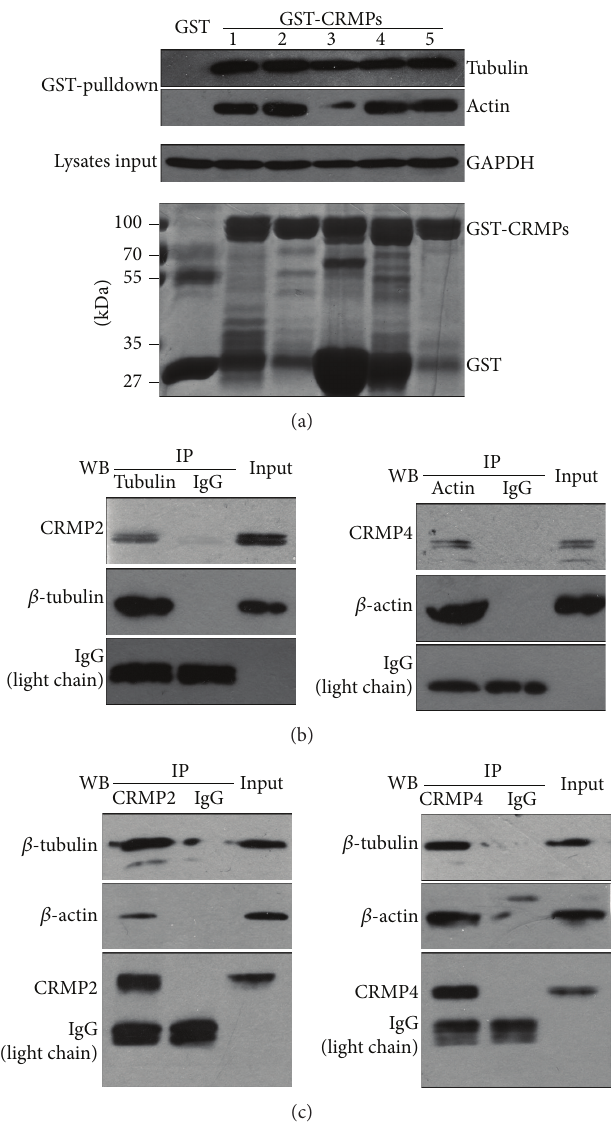
Figure 1: CRMP2 and CRMP4 interact with tubulin and actin. (a) Bacterial recombinant glutathione S-transferase- (GST-) CRMPs were purified and subjected to GST-pulldown assays with growth cone extracts from rat brain. Coomassie blue staining of GST and GST-CRMPs (bottom) showed equal loading of bait proteins. The pulldown sediments were subjected to western blot assays with tubulin and actin antibodies using GAPDH as the lysate input control. Each result is representative of three to five separate experiments with similar results. (b) Growth cone lysates from rat brain were subjected to coimmunoprecipitation (Co-IP) with tubulin or actin antibody and then processed for western blot (WB) analysis with the indicated antibodies. (c) Growth cones lysates were immunoprecipitated with CRMP2 or CRMP4 antibodies and processed for WB assays to detect the indicated proteins using the appropriate